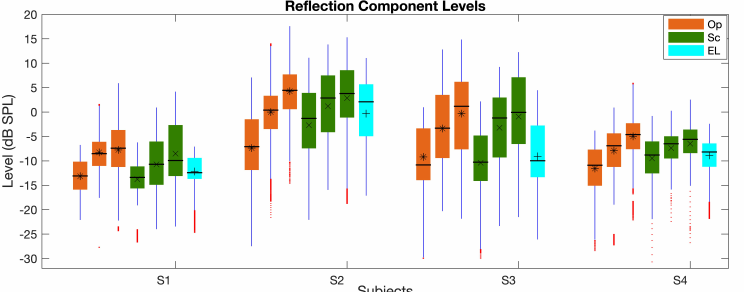
Figure 7. Boxplot of the L refl averaged at low, mid, and high L 2 s (three orange and green bars show the Op and Sc paradigms, respectively; the cyan bars show the mid-level values in the EL paradigm) across frequency. The central horizontal line, and the bottom and top edges of the boxes indicate the median, 25th and 75th percentiles, respectively. The averages of individual bars are indicated by the ∗ , × , + symbols (for the Op, Sc, and EL paradigms, respectively) inside the boxes. The whiskers extend to the most extreme data points and outliers are plotted using red dots. The subjects IDs (S1–S4) are indicated on the x-axis.